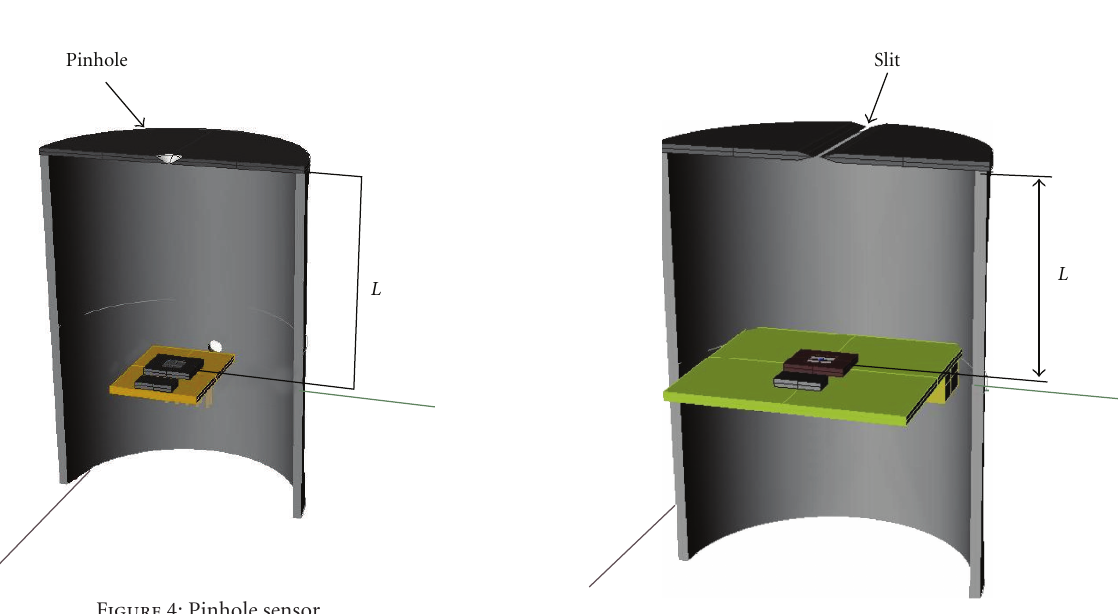
Figure 3: (a) A sun finder with 2 sections. (b) Scheme of the pointer in (a).